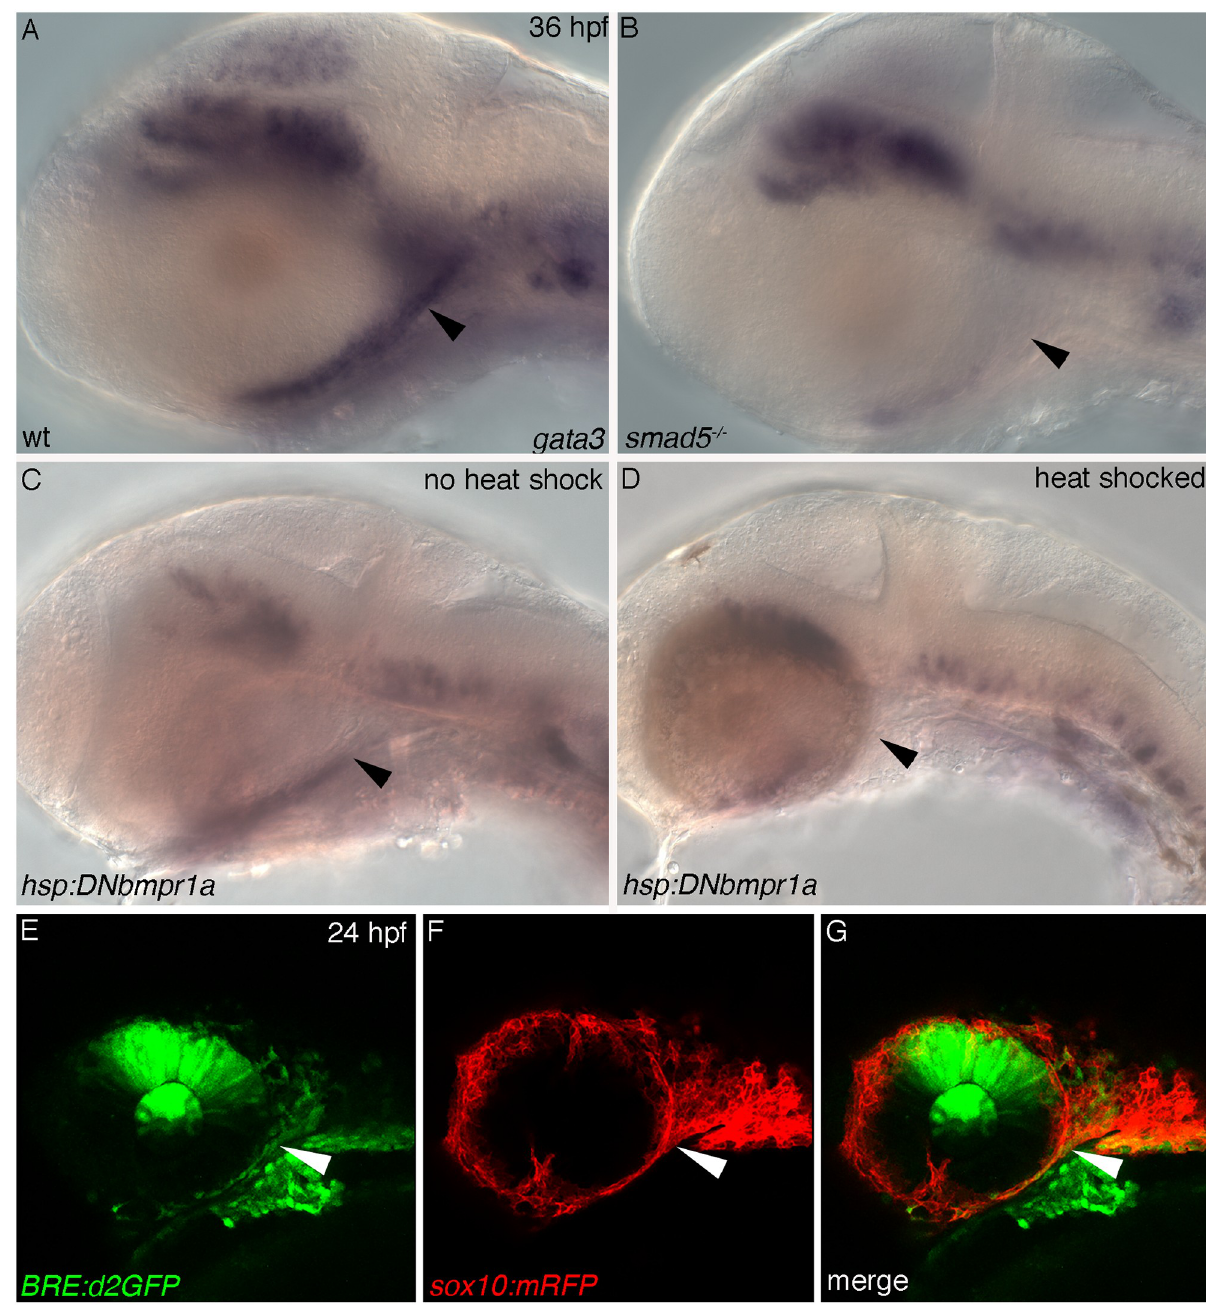
Fig 6. Bmp signaling to maxillary neural crest regulates the expression of gata3 . (A-D) Lateral views with anterior to the left of 36 hpf gata3 in situ hybridization black arrows point to maxillary crest that will give rise to trabeculae; white arrows mark the ear. (A-B) Embryos from a smad5 clutch. (A) Wild type embryo showing strong expression of gata3 in maxillary trabeculae precursors. (B) Mutant embryo showing loss of gata3 expression in trabeculae precursors. (C-D) Embryos from a hsp : DN-Bmpr1a clutch. (C) No heat shock embryo arrowhead indicates gata3 expression in maxillary precursors. (D) Embryo heat shocked at 24 hpf arrowhead indicates loss of gata3 expression in maxillary CNCC. (E-G) Confocal images of Bmp responsive cells (green, cytoplasmic) and CNCC (red, membrane tagged), lateral views with anterior to the left at 24 hpf. Arrow points to Bmp responsive maxillary neural crest